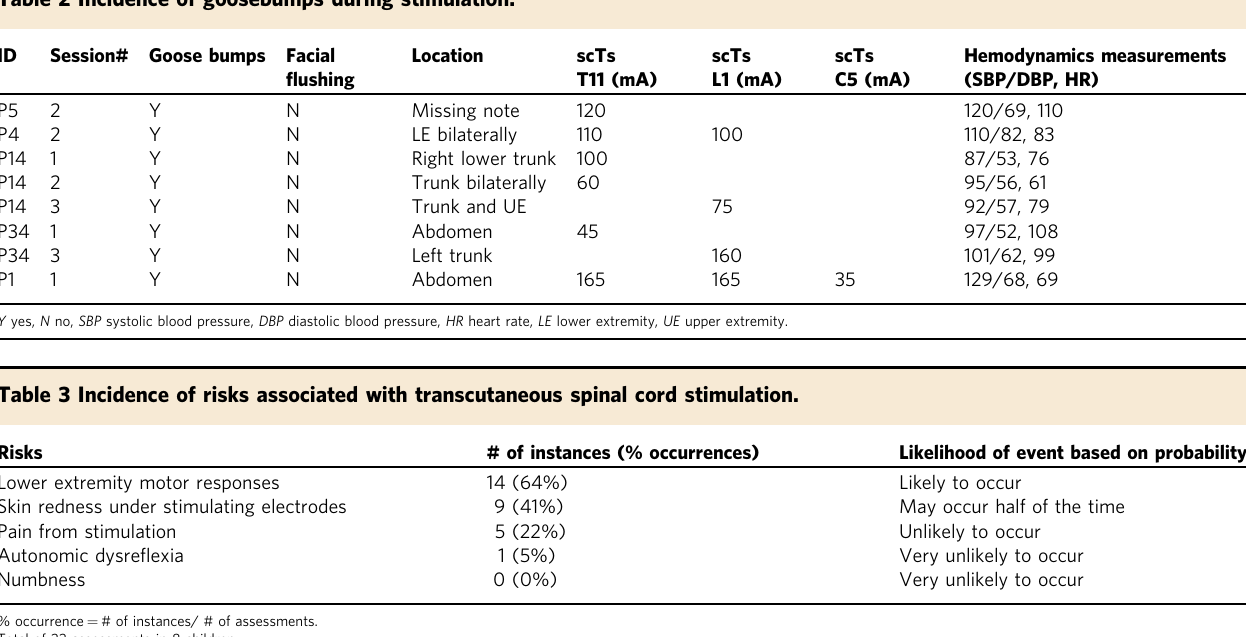
Table 2 Incidence of goosebumps during stimulation.